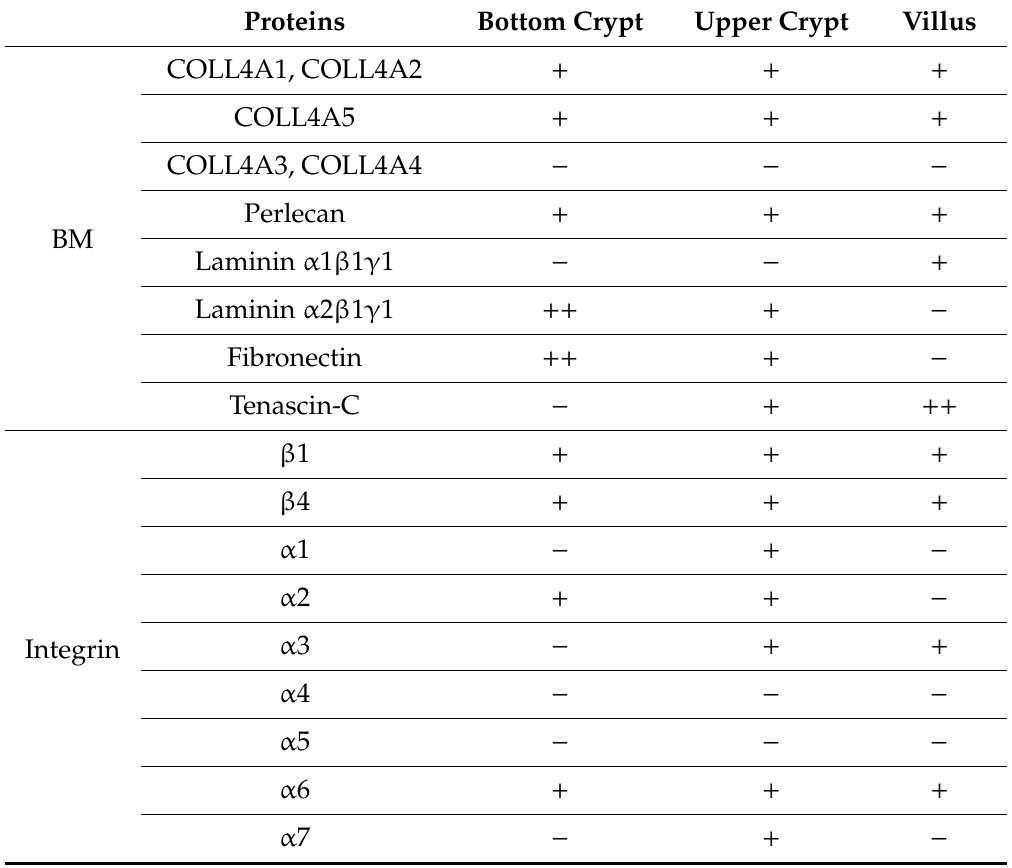
Table 1. Summary of the basement membrane (BM) components and cellular integrin di ff erential expressions along human small intestinal / colon tissues. COLL: